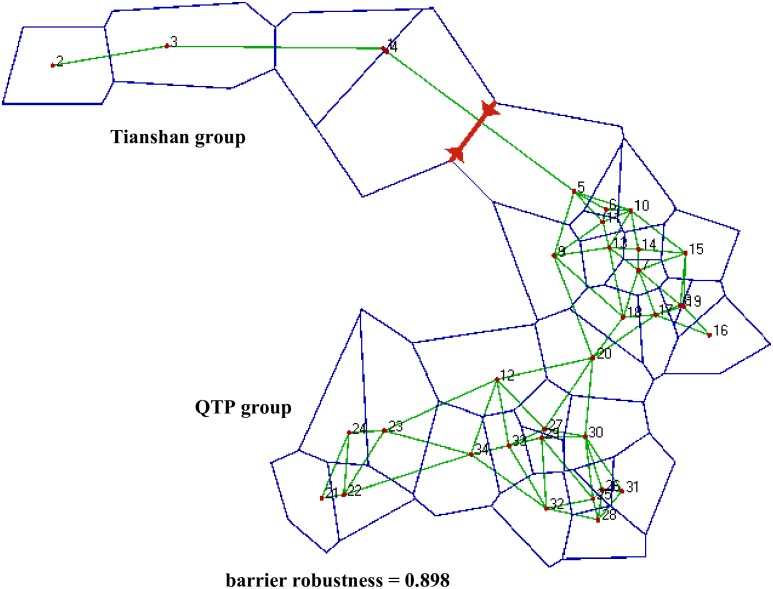
Location of inter-population genetic breaks in Pedicularis kansuensis in the Qinghai-Tibetan Plateau (QTP) and Tianshan region (TSR).Outlines represent the polygons of the Voronoï tessellation with the centers of the populations omitted. Red line represent the barrier. The distribution range of P. kansuensis was divided into two groups, Tianshan group (TSG) and QTP group (QTPG).